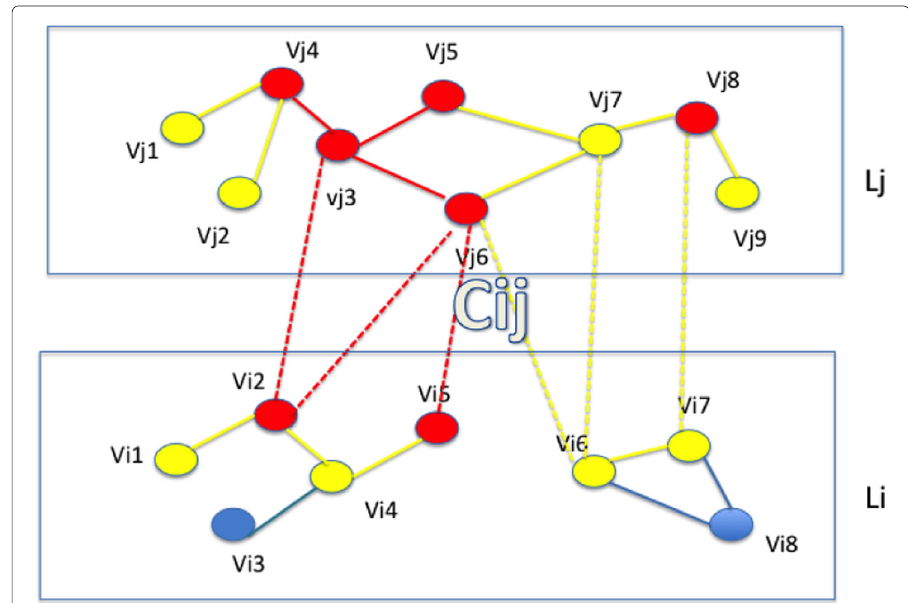
Fig. 5 Multilayer complex network: private egocentric network is represented by red and yellow nodes and edges